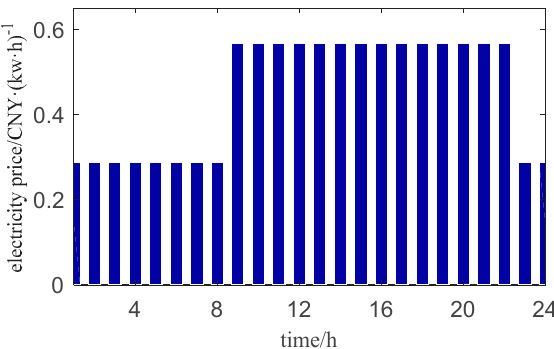
Figure 16. Changes in electricity prices within a day.